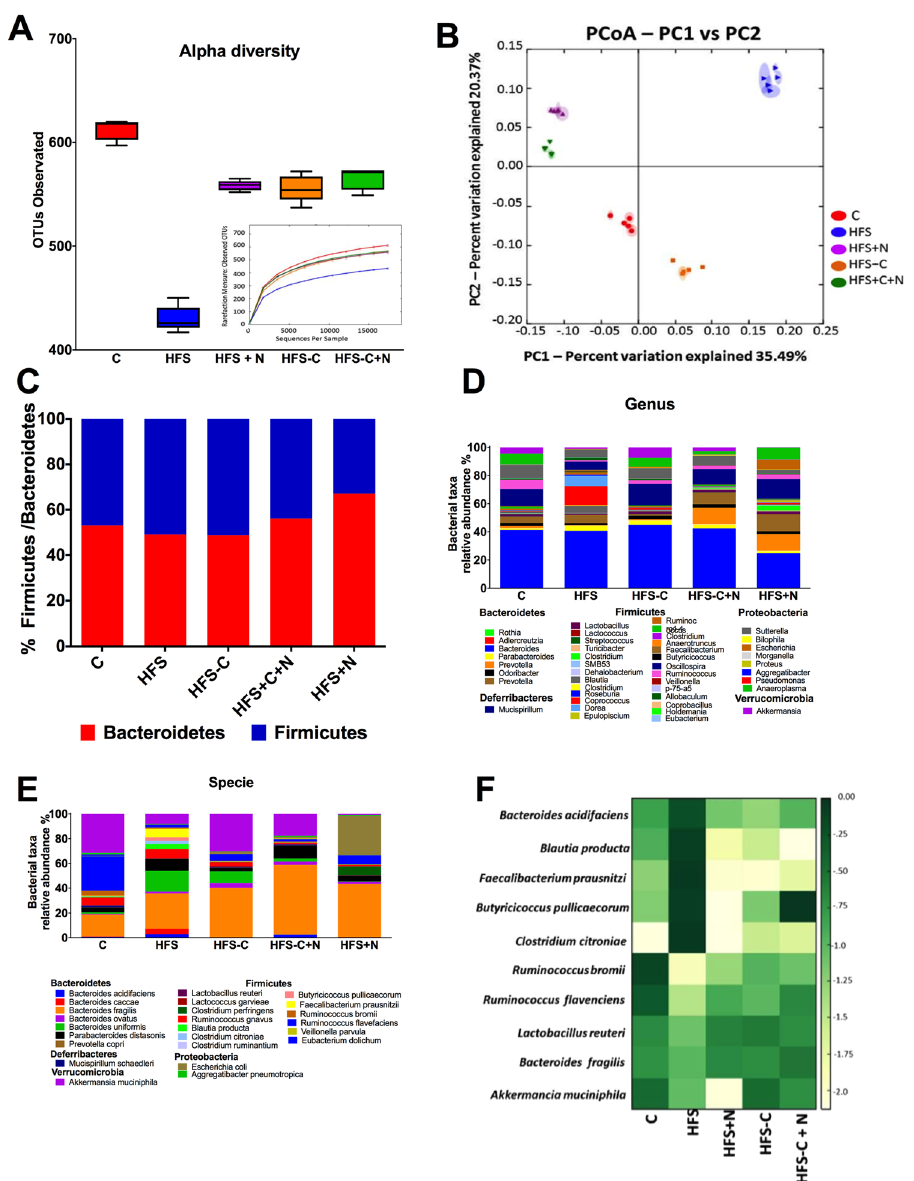
( C ) Relative abundance of Firmicutes and Bacteriodetes , ( D ) relative abundance of gut microbiota at the genus level, ( E ) and at species level and ( F ) heatmap of the ten bacterial species with greatest differences among